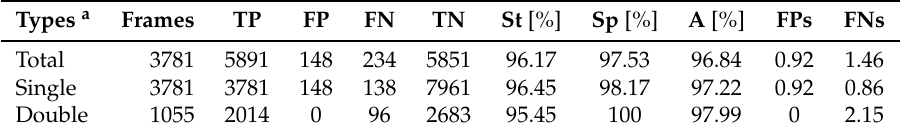
Table 1. Lane marking detection rate for a solid lane marking